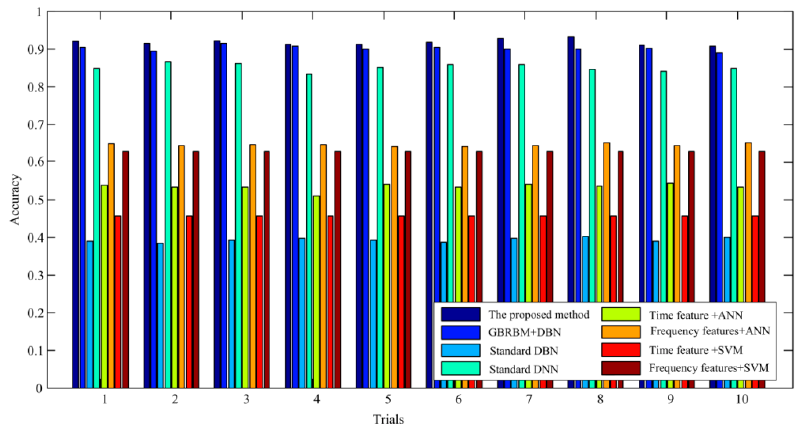
Figure 7. Averaged diagnosis accuracy of the ten trails under 500 rpm-500 Nm working condition.